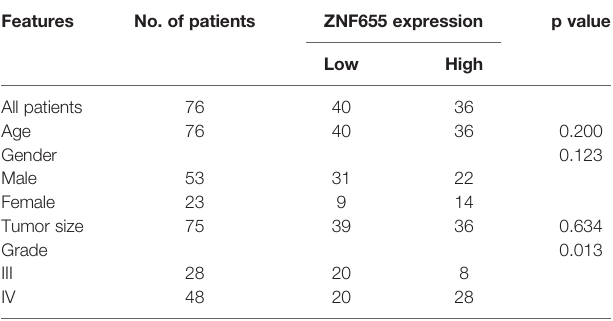
TABLE 2 | Relationship between ZNF655 expression and tumor characteristics in patients with high-grade glioma. Features